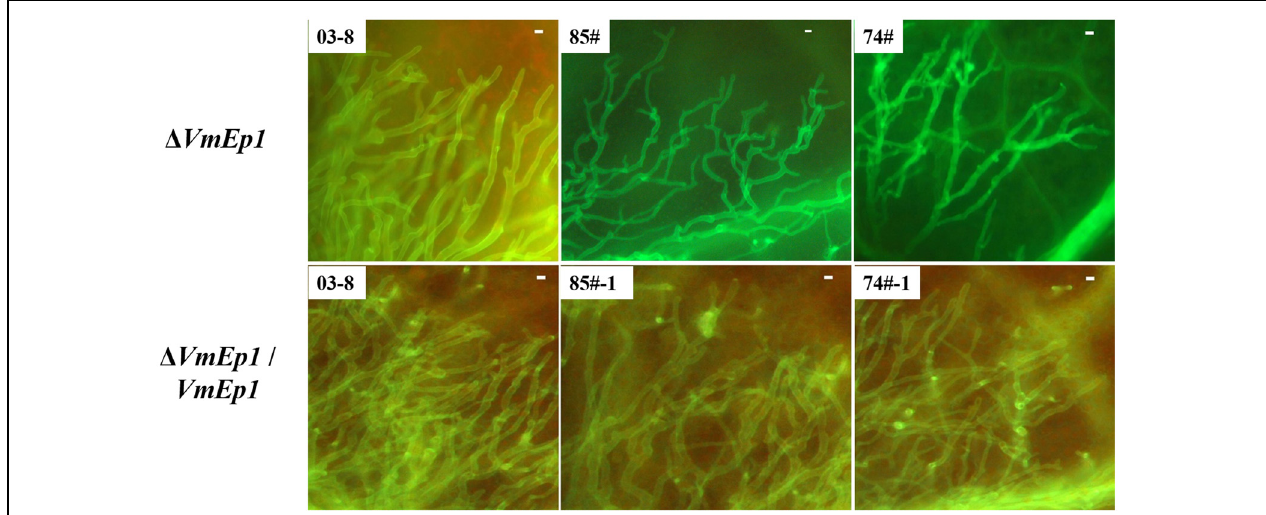
FIGURE 7 | Epifluorescence microscopy of tissue colonization during infection. Boundary-zones ( ∼ 0.5 cm 2 ) of inoculated leaves were sampled at 60 hpi. All treatments were performed with at least five replicates, and all experiments were repeated three times. Bar = 10 µ